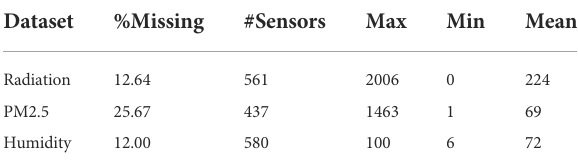
TABLE 1 Description of three